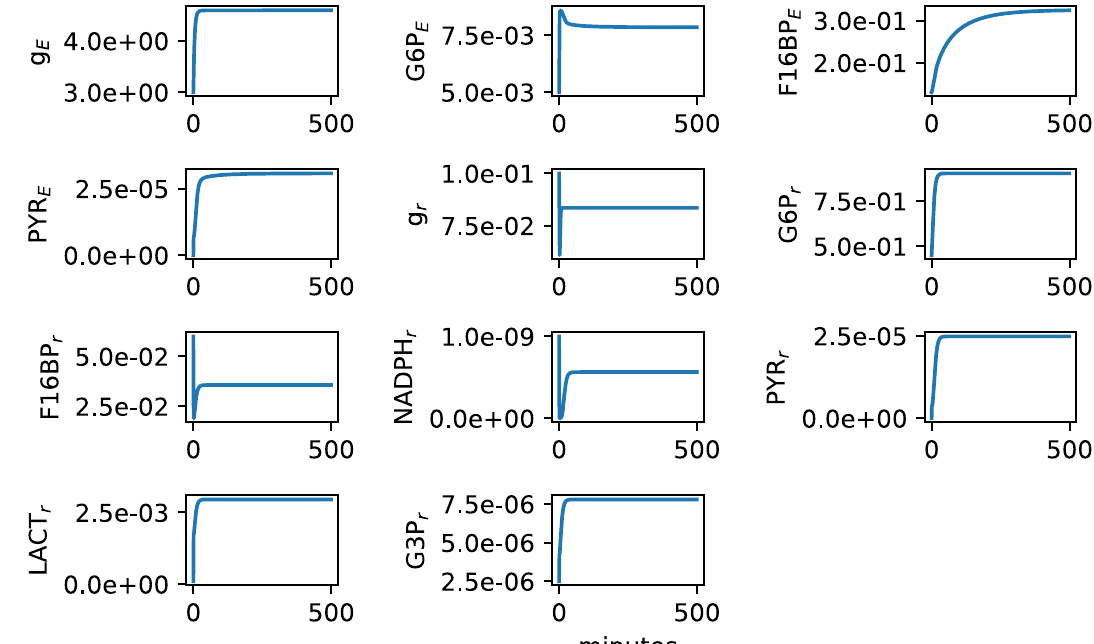
Figure 4. Metabolites’ steady state solutions. Here we show the time series resulting from numerically solving the system of differential Eqs. (1)–(11) for 500 min under healthy conditions, i.e., using the parameters and initial conditions of Table 1. Individual panels correspond to every node (metabolite) depicted in the network of Fig. 2, which is modeled by the differential Eqs. (1)–(11). Blue lines represent the concentration of the corresponding metabolite in time. After a short transient, or settling time, every metabolite reaches a feasible steady state. We refer to this steady state concentration as the healthy concentration or the healthy case , as it represents a qualitative baseline for analysing how the system responds to perturbations.